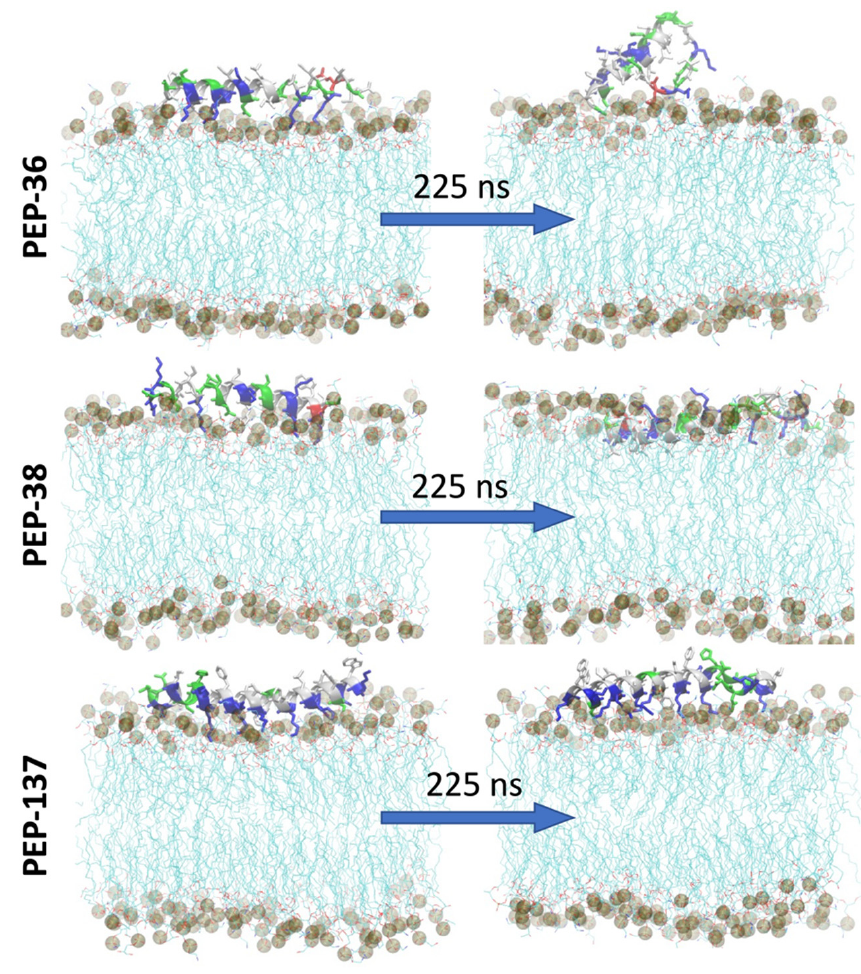
Figure 4. Initial and final snapshot of peptide-membrane system before and after 225 ns of MD simulation. The membrane is shown in lines (cyan) and the peptides are shown in helical structure (colored according to the type of amino acids). Phosphate atoms of the membrane are shown in gray color.